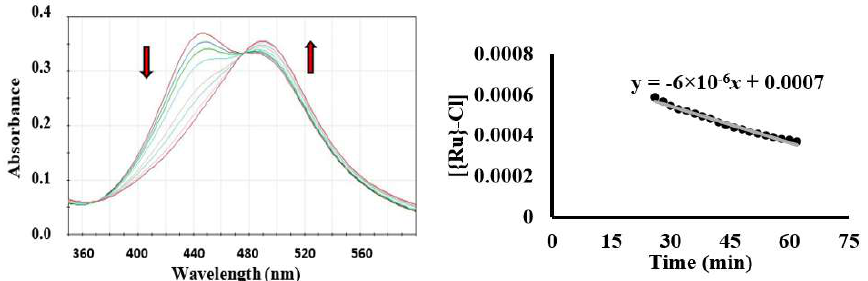
Figure 1. The changes in the absorption spectrum of complex 1, showing chloro/aqua exchange upon dissolution in 10% water in DMSO.